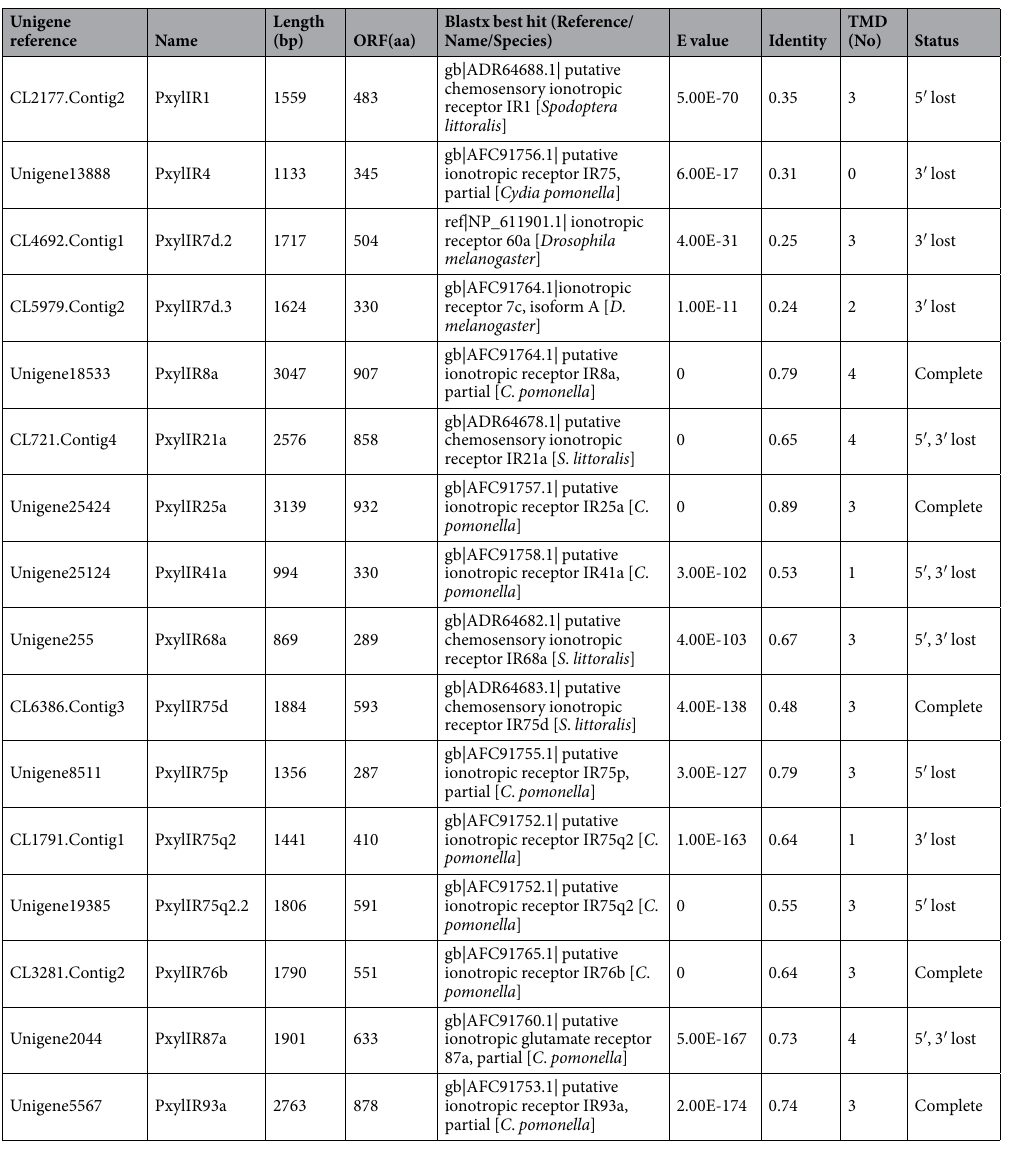
Table 3. Candidate ionotropic receptor